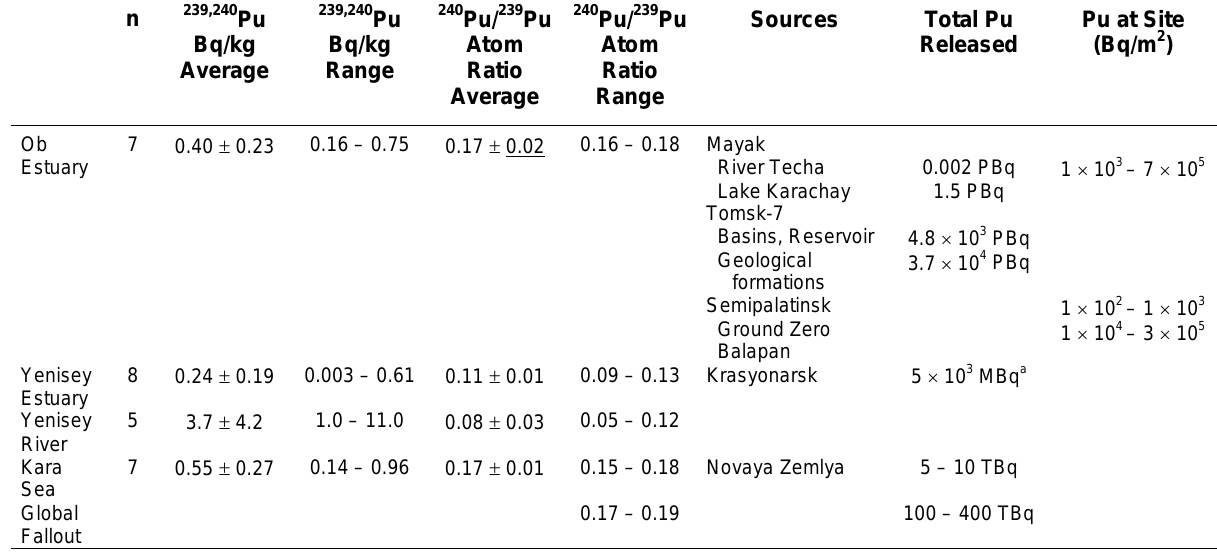
Summary of Results of Measurements in River Yenisey and the Ob and Yenisey Estuaries, Together with Possible Sources of